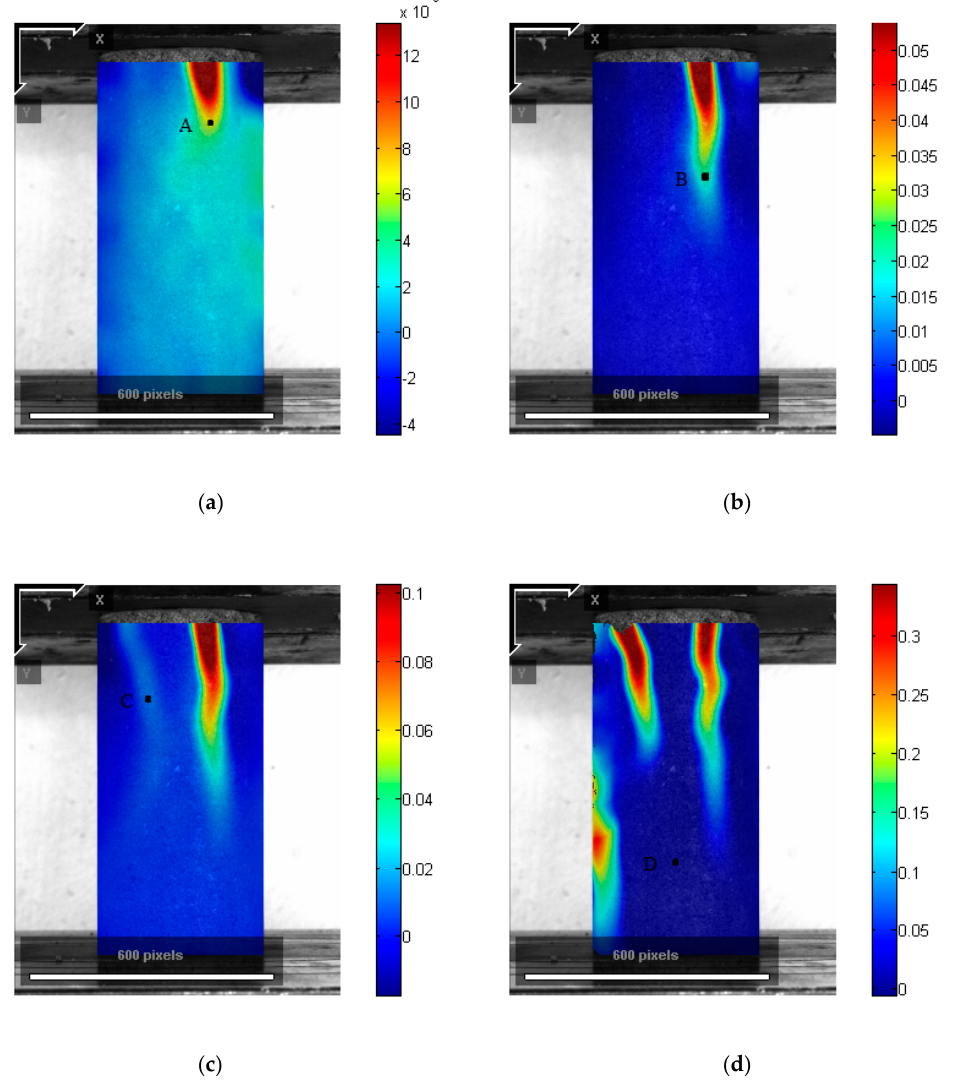
Figure 5. Strain dynamics along the x-direction (loading rate = 0.1 MPa/s): ( a ) t = 131 s; ( b ) t = 139 s; ( c ) t = 140.5 s; ( d ) t = 141 s.